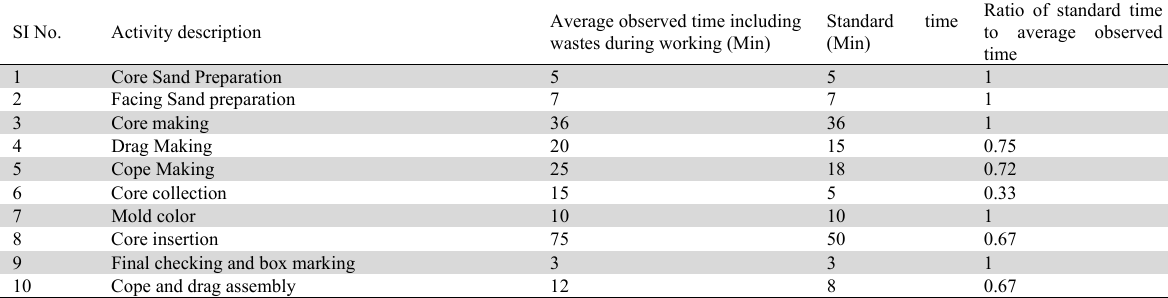
Time study for mold making process in foundry